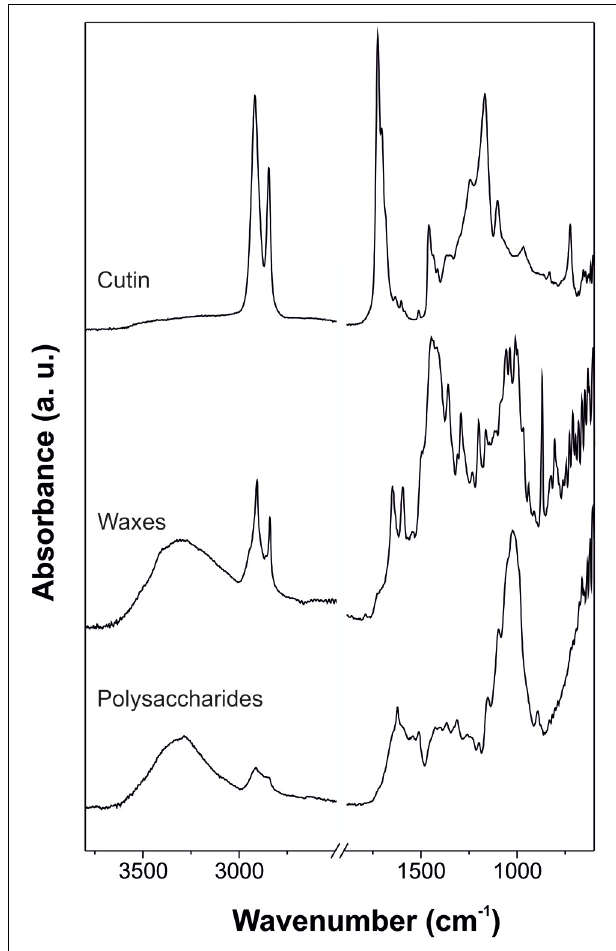
FIGURE 4 | ATR-FTIR spectra of cutin (adapted from España et al., 2014, with permission of John Wiley and Sons), waxes (adapted from Heredia-Guerrero et al., 2012, with permission of Elsevier), and polysaccharides (adapted from López-Casado et al., 2007) of isolated tomato fruit